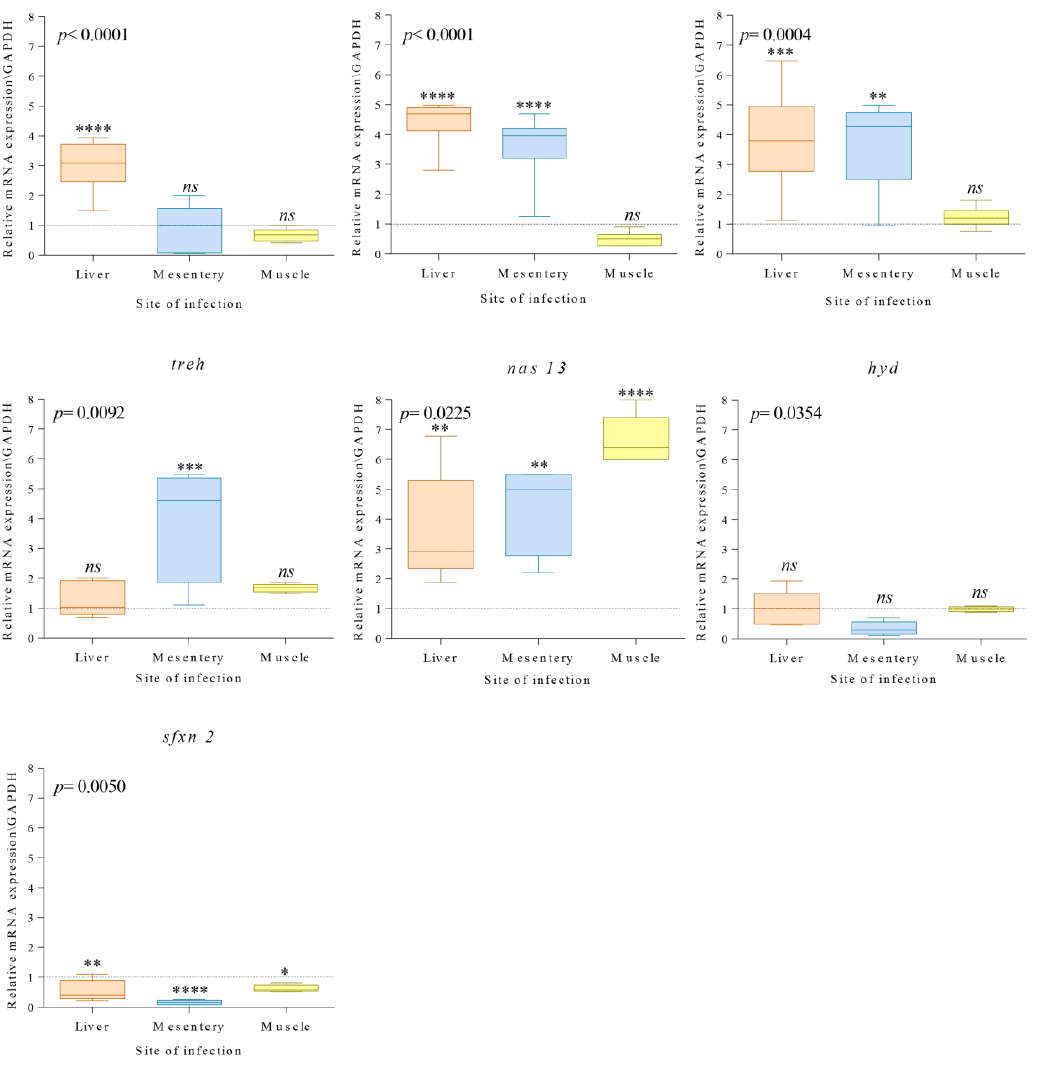
Figure 1. Box-plot representation of relative expression profiles of 7 genes coding for proteins, i.e., TI, hb, GP, treh, nas 13 , hyd, sfxn 2, normalized to the geometric mean of gpd in Anisakis simplex (s.s.) larvae infecting different host-fish tissues (liver, mesentery, muscle). The control, represented by larvae recovered in the stomach lumen of the fish host, is given as normalized to a value of 1 (dashed line). Each box shows the minimum, first quartile, median, third quartile, and maximum gene expression values of three biological replicates. Asterisks indicate the significance level of the differences between each group of A. simplex (s.s.) larvae from different sites of infection and the control group.